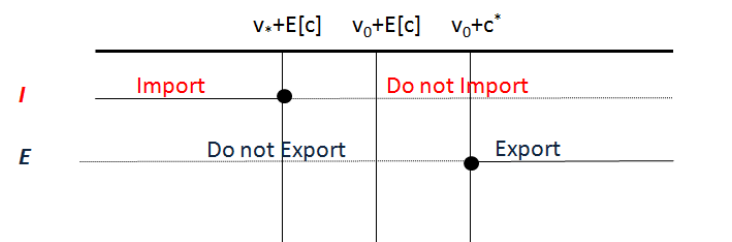
Figure 2. Ambiguity case: trade between the two agents breaks